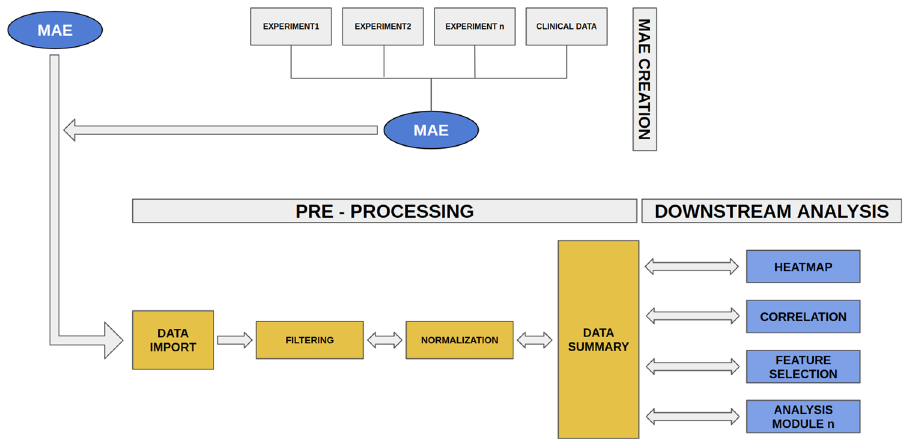
Figure 1. MuSA Architecture and Framework. Our architecture is modular and can be divided in two principal sections: pre-processing and Downstream analysis. In the first section, we also include the data upload module. The latter can accept both MAE or separated experiments (csv or summarizedExperiments) that will be transformed in a MAE by the MAE Creation sub-module. A MAE object is, thus, the input of Data Import module that provides a graphical summary of all experiments contained in the object. The next module in the workflow allows filtering the data by experiments, assays, features and complete data. Normalization module is optional, whereas Data Summary is mandatory. All modules that produce a tangible result are in the Downstream Analysis section. Double arrows between Filtering, Normalization, Data Summary and all Downstream Analysis modules indicate that the user can go back in the workflow and change the data environment (for example, deleting a feature or choosing another experiment). The results will change dynamically as in a classical Shiny